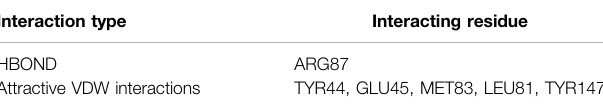
TABLE 1 | Criteria for the fi ltering of the docked 913,000 molecules from the Enamine HTS